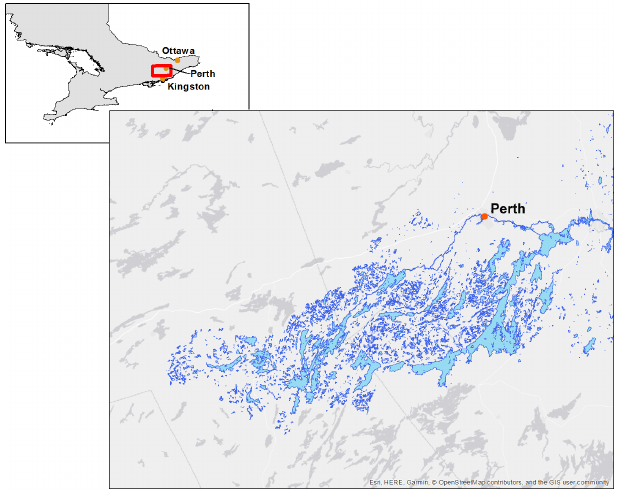
Fig. 1 . A map of the study watershed and its location in southern Ontario, with the major cities of Ottawa and Kingston, Ontario and the regional center of Perth,